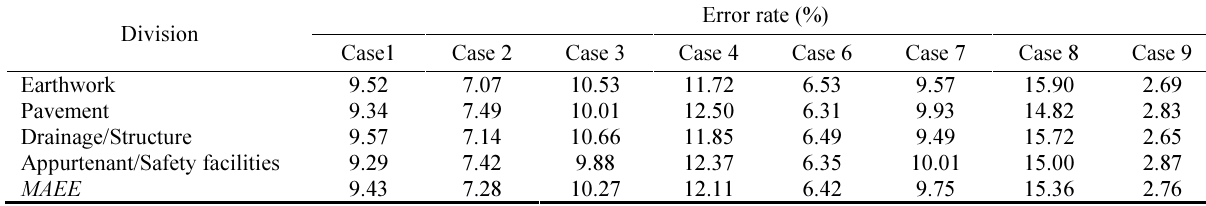
Table 7. The error rate of each cost division (1-fold)